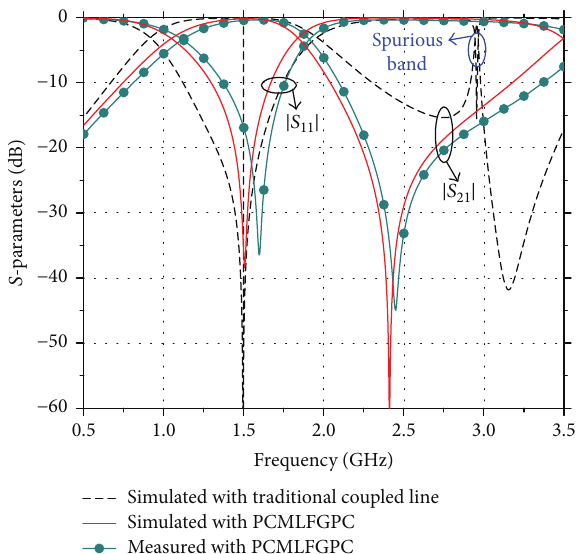
Figure 12: Comparison of the performances of bandpass filters configured with traditional parallel coupled microstrip lines or the